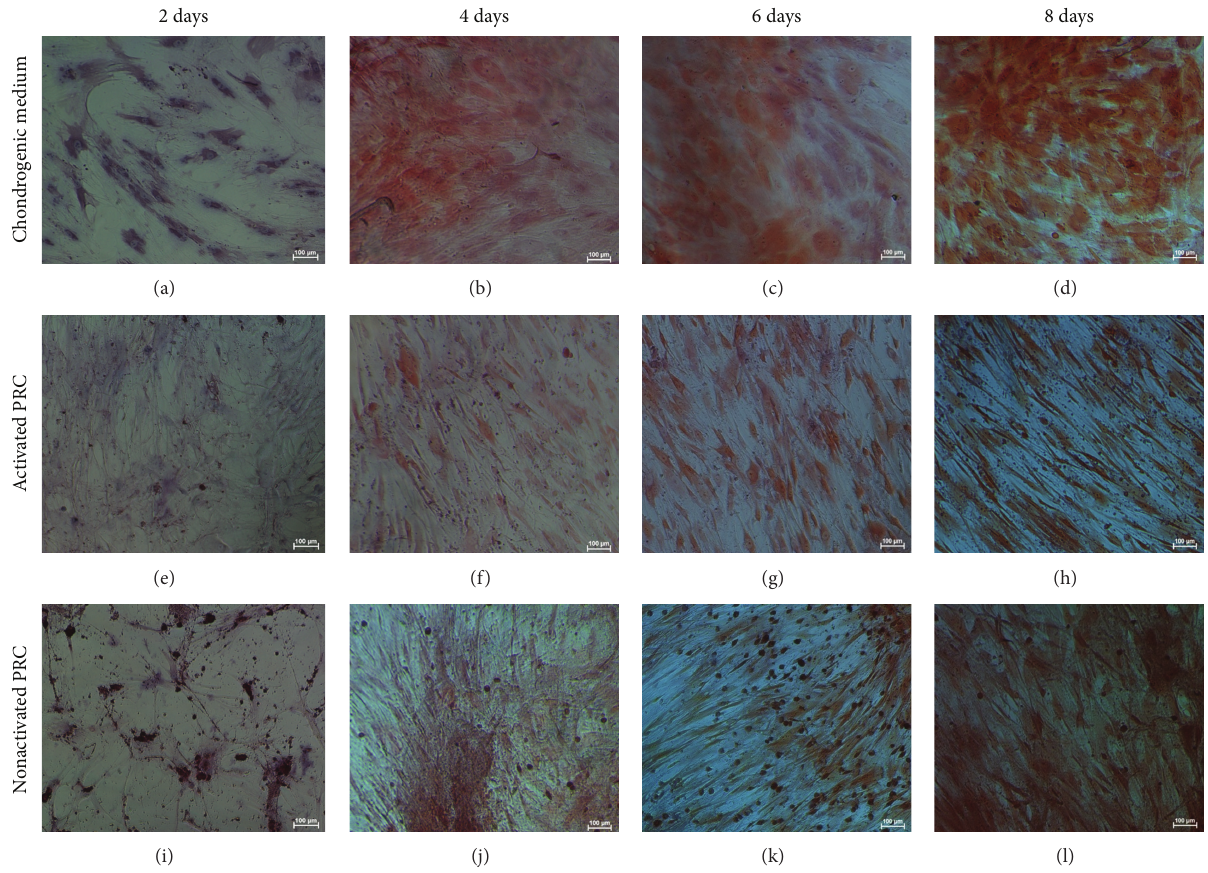
Figure 9: Cells stained with Safranin O. Cells cultured in chondrogenic medium (a)–(d), activated PRC (e)–(h), and nonactivated PRC (i)– (l). Cells cultured in PRC were fixed with formalin after each time point and were stained with Safranin O. Cells cultured in chondrogenic medium served as the positive